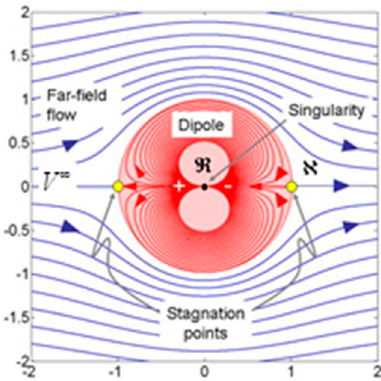
Figure A5. Flow paths tracked for far-field fluid (blue particles) and injection fluid (red particles). The doublet singularity has non-dimensional strength D m = 1 and the far-field flow-rate V ∞ = 1. Upstream and downstream stagnation points are marked (yellow dots). Local domain radius is controlled by the relative strength of the dipole and far-field flow rate in the external domain [61].